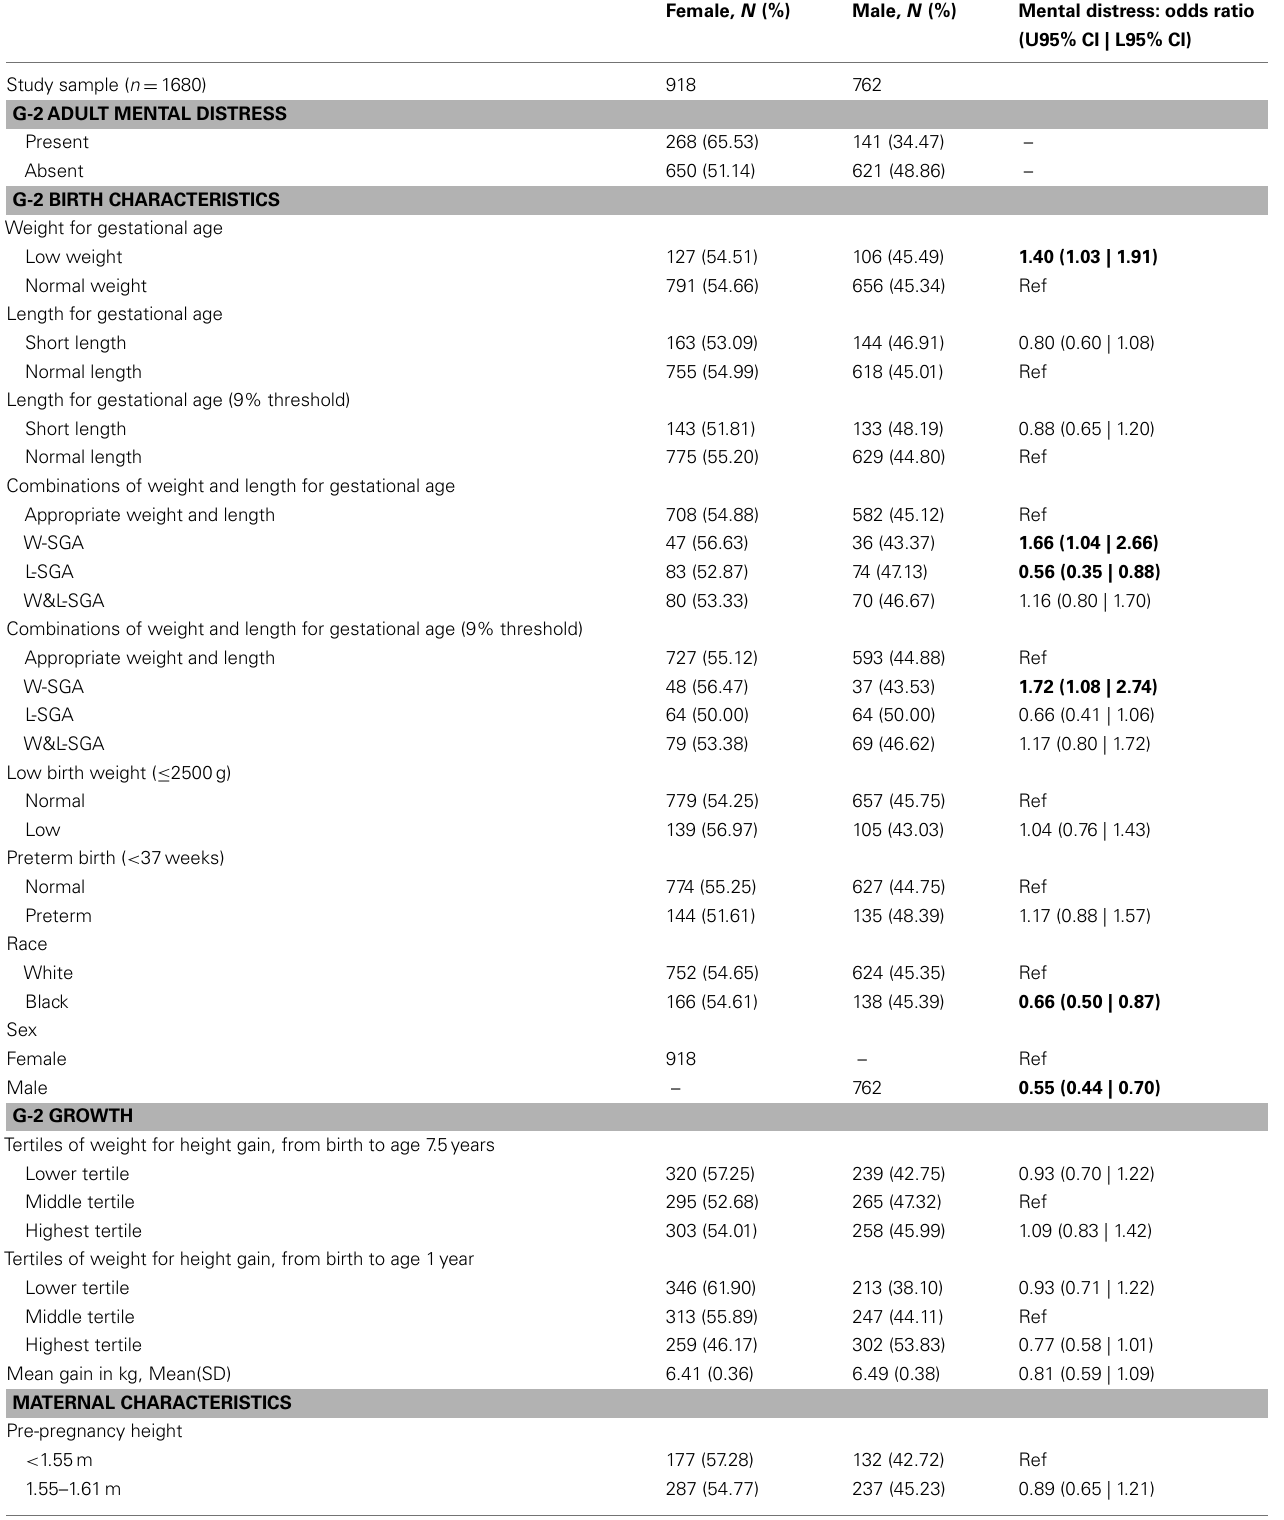
Table 1 | Frequency distributions of predictors and outcomes by sex; bivariate relationship of mental distress and study